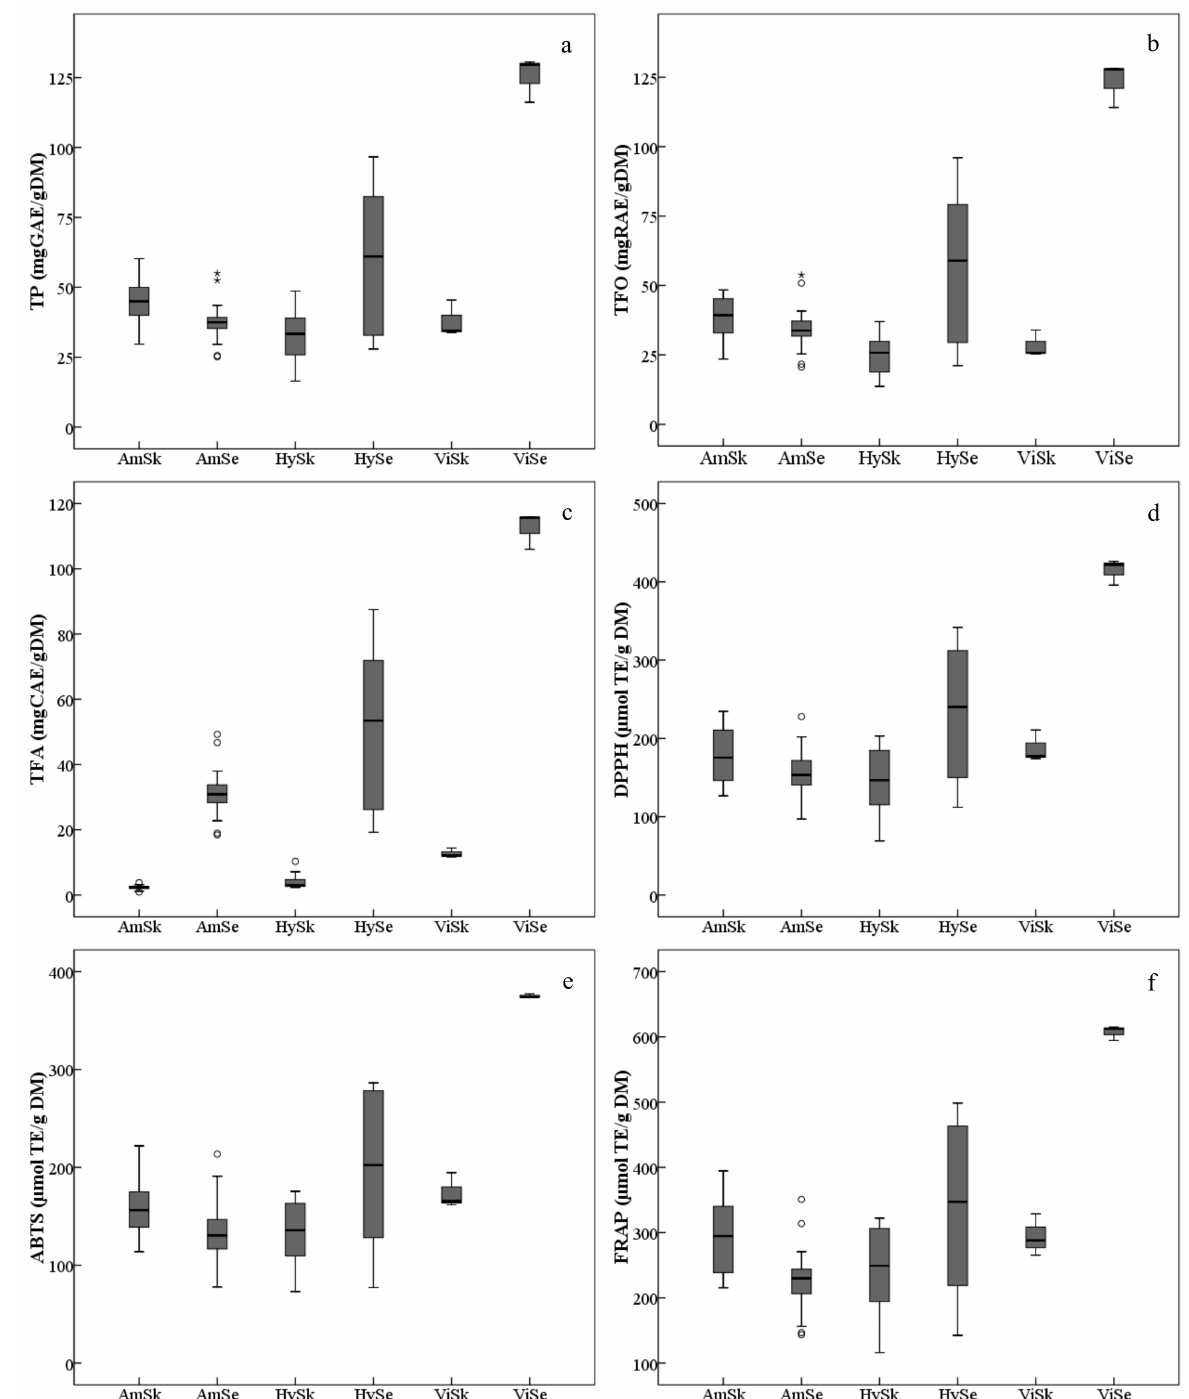
Figure 2. Ranges and distributions of total phenolics (TP, ( a )), total flavonoids (TFO, ( b )), total flavan-3-ols (TFA, ( c )), DPPH free radical scavenging activities (DPPH, ( d )), ABTS free radical scavenging activities (ABTS, ( e )) and ferric ion/reducing antioxidant powers (FRAP, ( f )) of ripe berry skins (Sk) and seeds (Se) belonging to the three grape groups from 2017 and 2018. The hollow dots and asterisks outside the whiskers indicate the mild and extreme outliers, respectively. The abbreviations of grape groups follow Figure